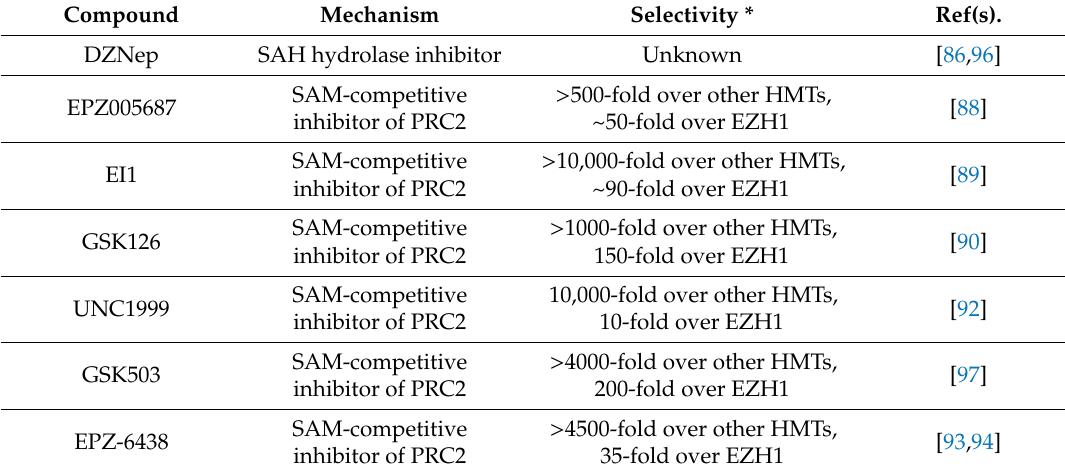
Table 1. Small molecules with EZH2-inhibiting